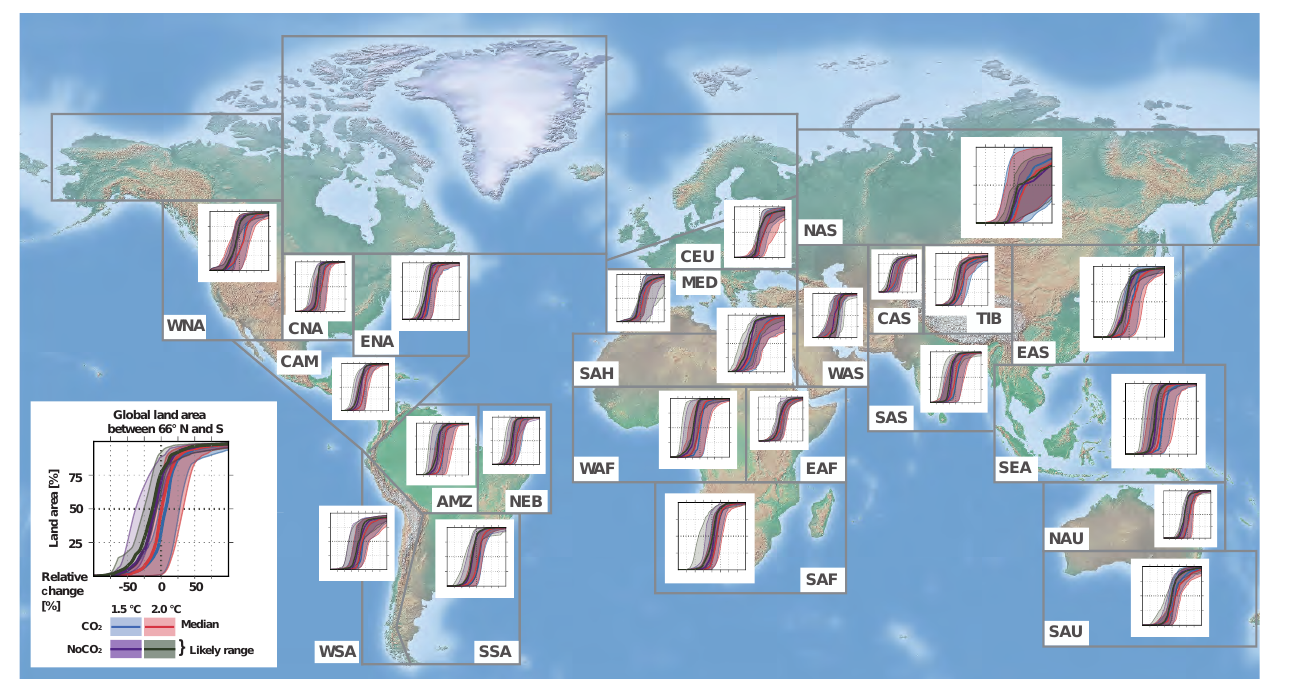
Figure 11. Same as Fig. 9, but for changes in soy yields.